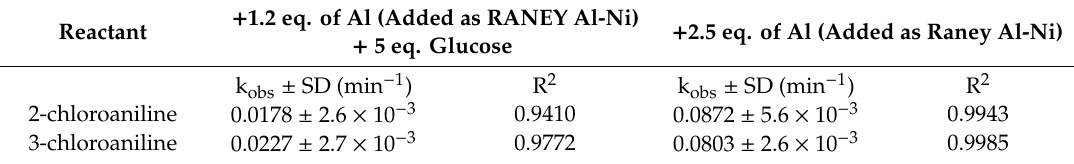
Table 2. Observed rate constants for HDC of Cl-ANs using the Raney Al-Ni alloy described in Figure 2 (and [23]), evaluated based on a non-linear regression analysis (applying a pseudo-first order model).